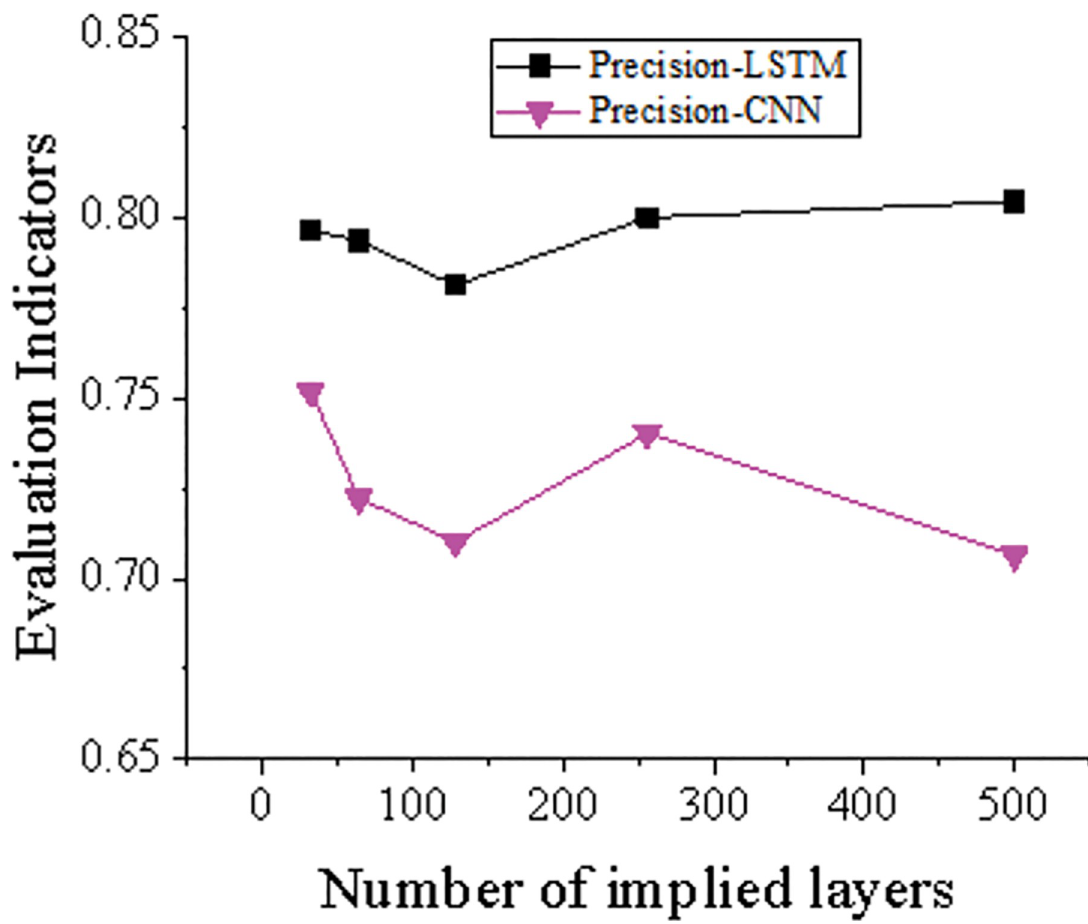
Fig 12. Comparison results of different